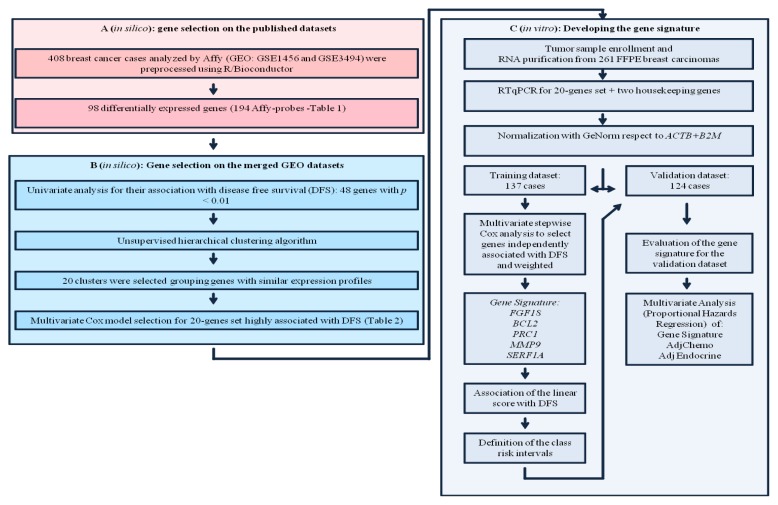
Construction of the gene-set predictor/gene signature for risk prediction. (A) Gene selection on the published datasets; (B) Gene selection on the merged Gene Expression Omnibus (GEO) datasets; (C) Developing the gene signature.